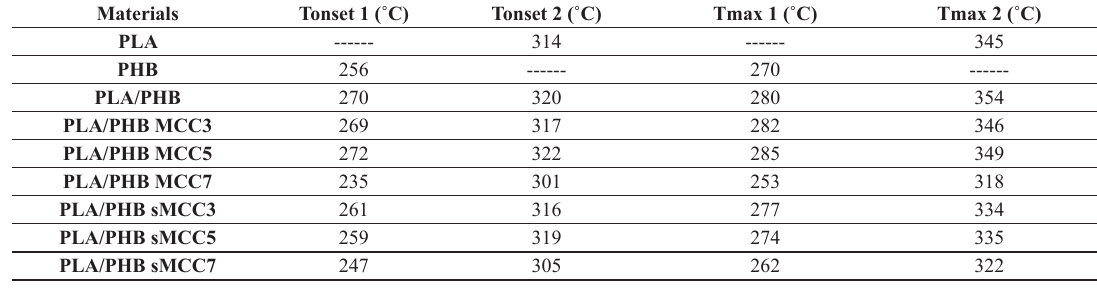
Table 3. TGA data obtained for PHB, PLA, PLA/PHB blend and their biocomposites systems.